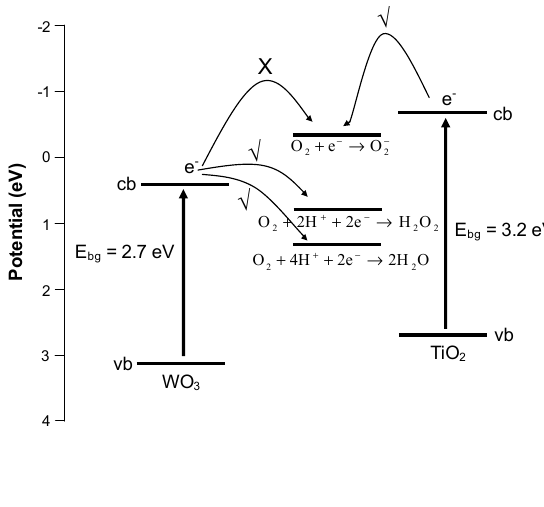
Figure 5. Valence and conduction band potentials for WO 3 and single and multi-electron potentials for oxygen. The valence and conduction band potentials for TiO 2 are included for